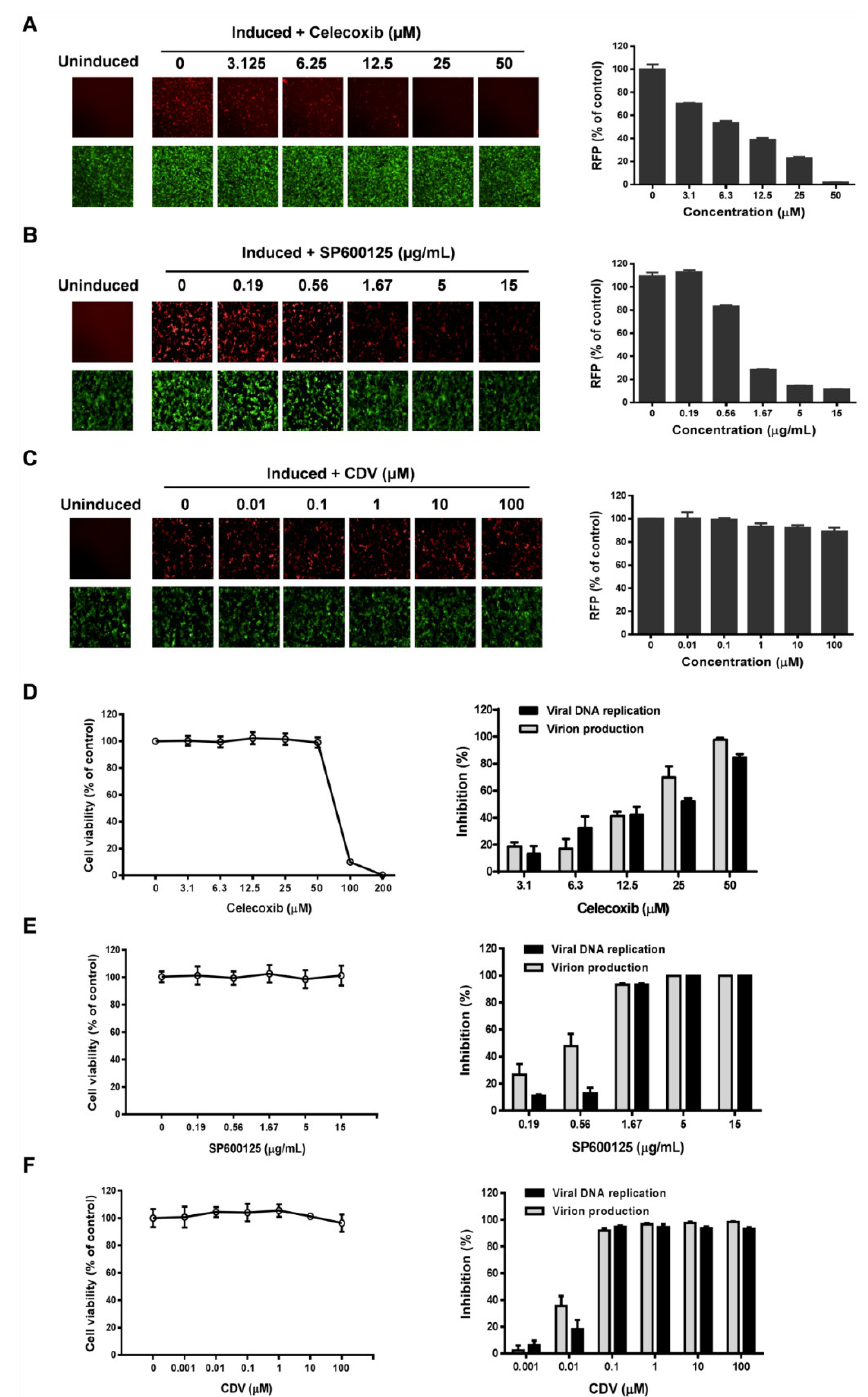
Figure 3. Celecoxib affects the early stages of KSHV reactivation from latency in iSLK.219 cells. The iSLK.219 cells were lytically induced with Dox (1 µg/mL) and NaB (1.2 mM) in the presence of various concentrations of test compounds for 24 h. The effect of celecoxib ( A ), SP600125 ( B ) and CDV ( C ) on the expression and of RFP or GFP were detected by fluorescence microscopy (left panel), and the fluorescence intensity of RFP was quantified with the HCS system as described in the Methods (right panel); The cytotoxicity and the inhibition of viral DNA replication and production of mature virions of celecoxib ( D ), SP600125 ( E ) and CDV ( F ) to iSLK.219 cells were determined by CellTiter-Glo ® Luminescent Cell Viability